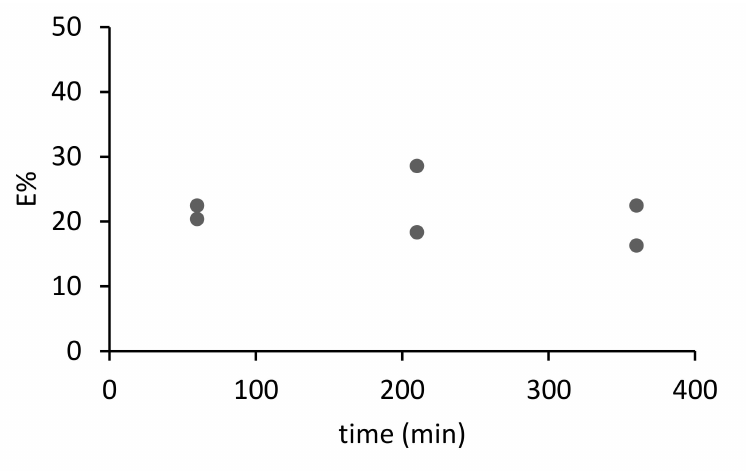
Figure 6. Kinetics of sorption of arsenate (0.5 mg L − 1 As) with M1 in SNW ( n = 2) .